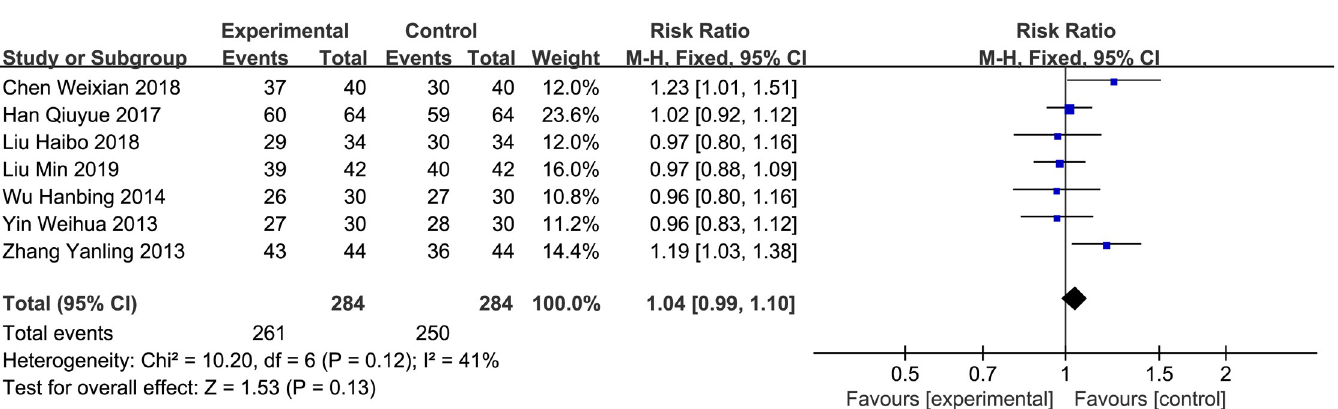
manage pain using oral analgesics, simple alternatives to oral medications in the near-terminal state remain unresolved. Intramuscular, intravenous, and subcutaneous injections are uncom- fortable and expensive for patients; they are also impractical in the home environment. As a rectal suppository, OxyContin effectively manages pain, facilitates the administration of